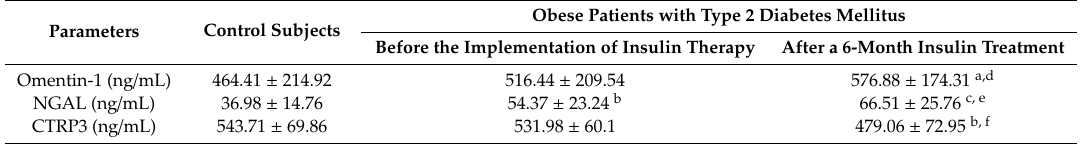
Table 2. Concentrations of plasma omentin-1, NGAL and CTRP3 in control subjects and obese patients with type 2 diabetes